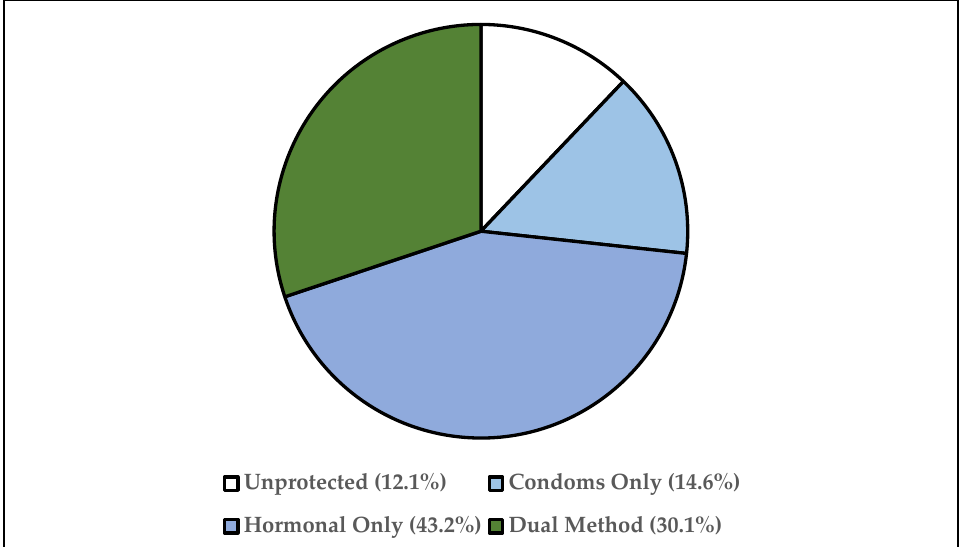
Figure 2. Pregnancy and STI Prevention at Last Vaginal Sex ( n = 438).